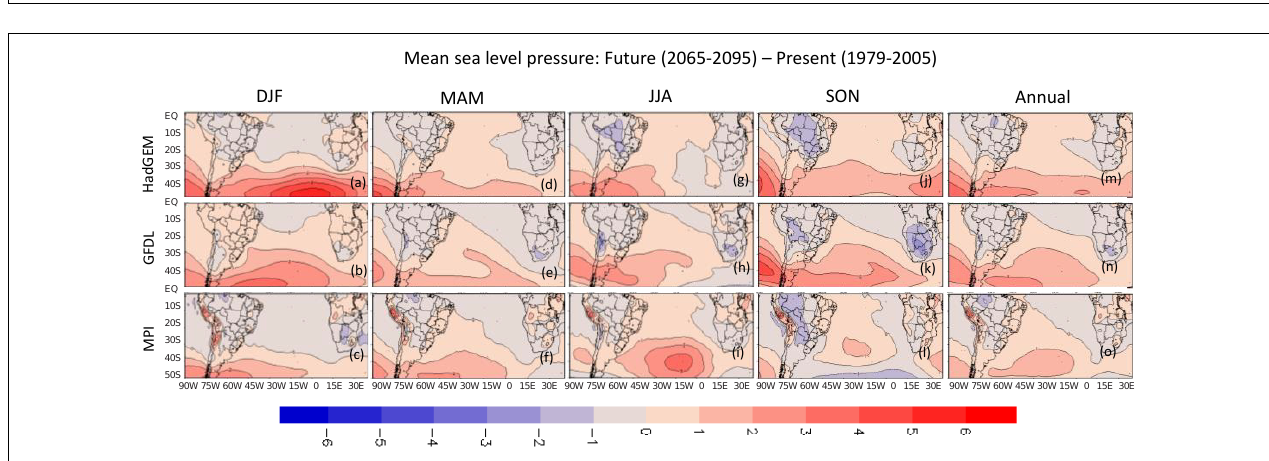
FIGURE 6 | Seasonal and annual climatologies of the mean sea level pressure (hPa) in the future climate (2065–2095) from HadGEM (a,d,g,j,m) , GFDL (b,e,h,k,n) , and MPI (c,f,i,l,o) global climate models. Isobars interval is 2 hPa.